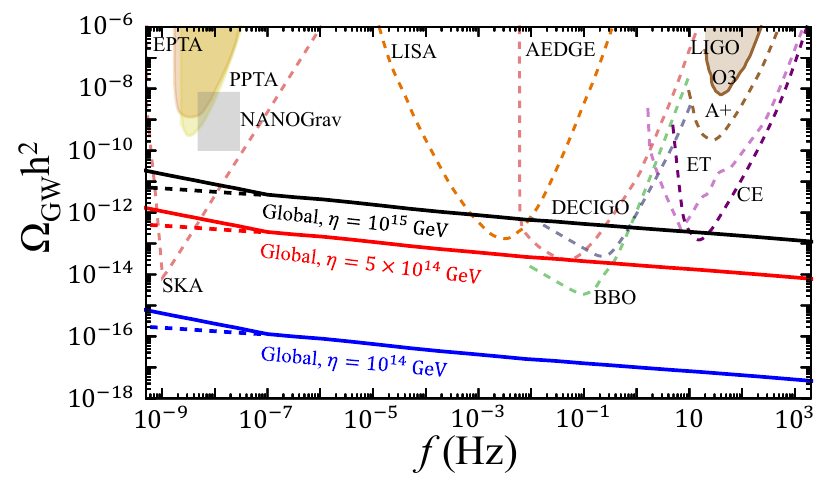
Figure 4 . Gravitational wave spectrum from a global cosmic string network with α = 0 . 1 , F α = 0 . 1 for η = 10 14 , 5 × 10 14 , 10 15 GeV. The solid curves shown are the full results with standard cosmology, dashed lines show the contribution from emission during radiation domination. Exclusion limits or projected sensitivities with various GW experiments are also